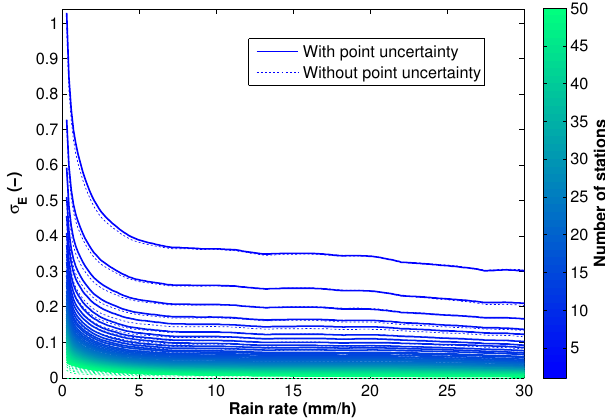
Figure 4. Standard deviation of the relative rainfall error as a func- tion of rain rate for different numbers of subsampled stations for 1000 Monte Carlo realisations for the Brue catchment, with and without point